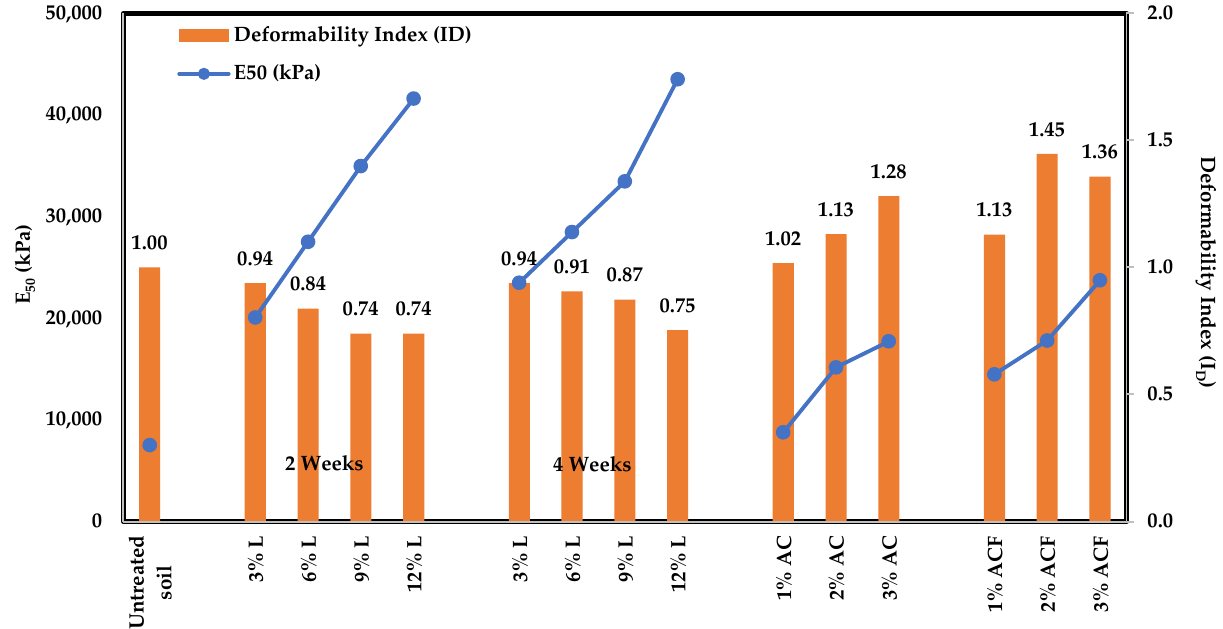
Figure 8. Deformability index (I D ) and elastic modulus (E 50 ) of lateritic soil and treated soil.